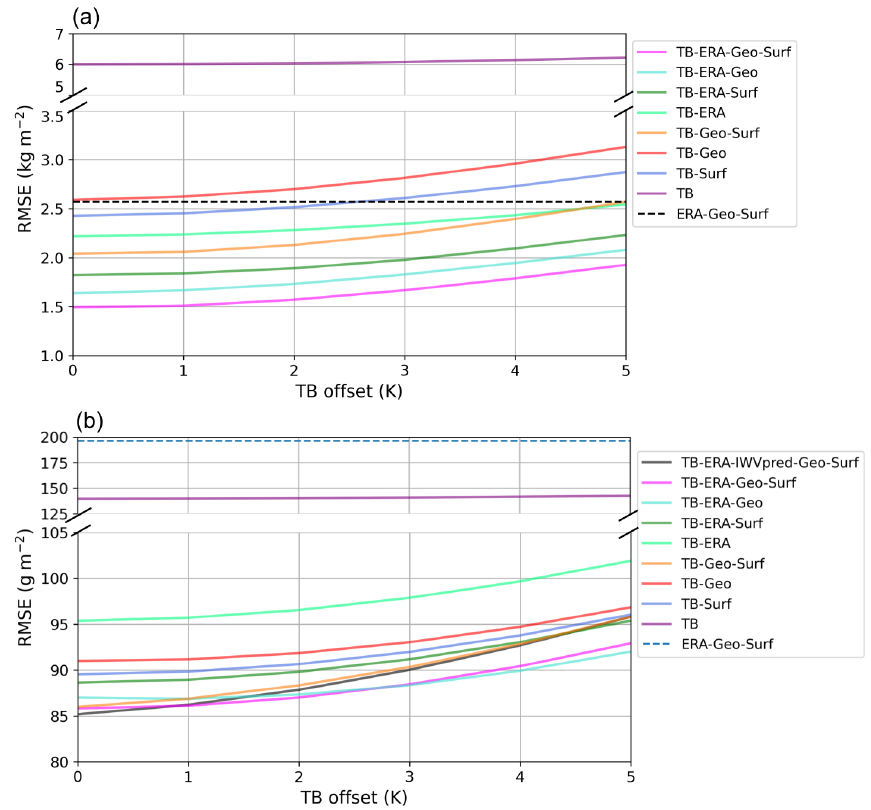
Figure 7. RMSE for the testing set of the different versions of the (a) IWV and (b) LWP retrieval after the addition of a constant T B offset in the input. Dashed lines show the retrievals without T B in the input